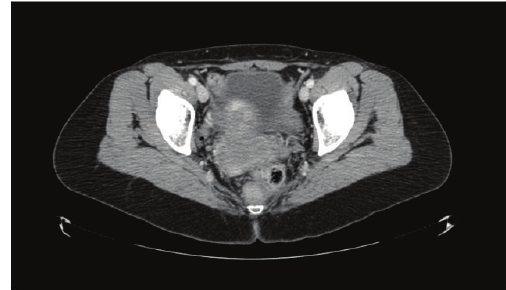
Figure 1: Monotonous neoplastic proliferation of atypical lym- phoid cells (H&E 20x).